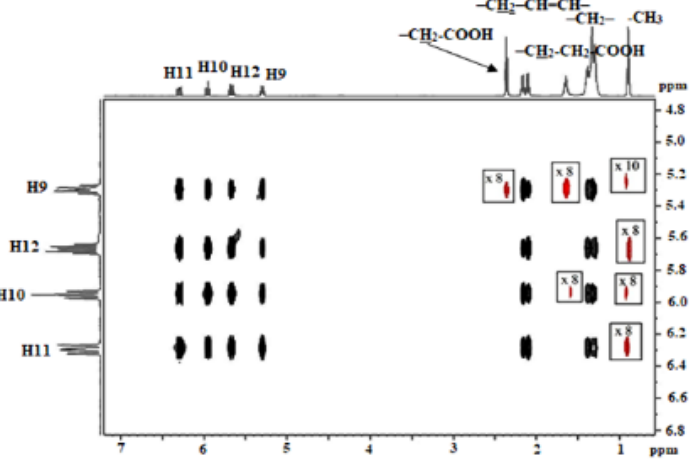
Figure 17. Selected region of 500 MHz 2D 1 H- 1 H TOCSY NMR spectrum of (9- cis , 11- trans ) 18:2 CLA (solution conditions the same as in Figure 16). Mixing time τ m = 100 ms, number of scans (ns) = 16, number of increments = 256, total experimental time = 2 h 39